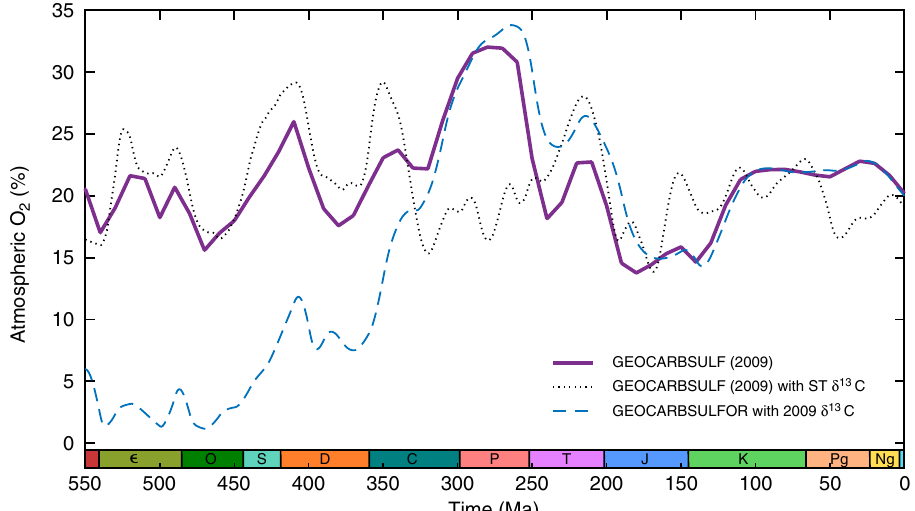
Fig. 4 Sulphur cycle versus carbon isotope modi fi cations. The purple line is the original GEOCARBSULF p O 2 prediction 21 , the black dotted line is the original GEOCARBSULF model but with the δ 13 C record updated to use data from Saltzman and Thomas 48 , and the blue dashed line is GEOCARBSULFOR but with the isotope data from the original GEOCARBSULF